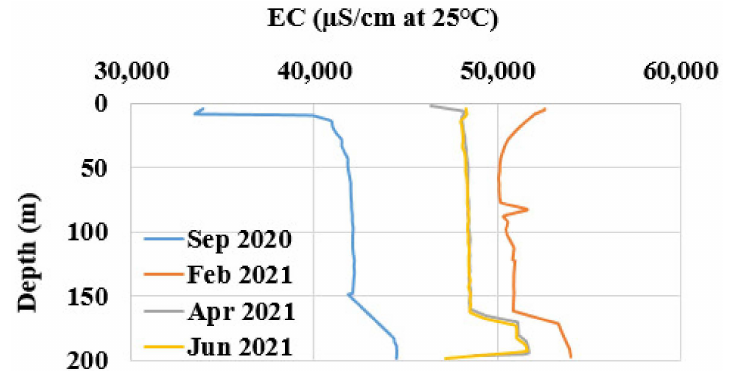
Figure 11. Vertical EC logging values within well TK4 during